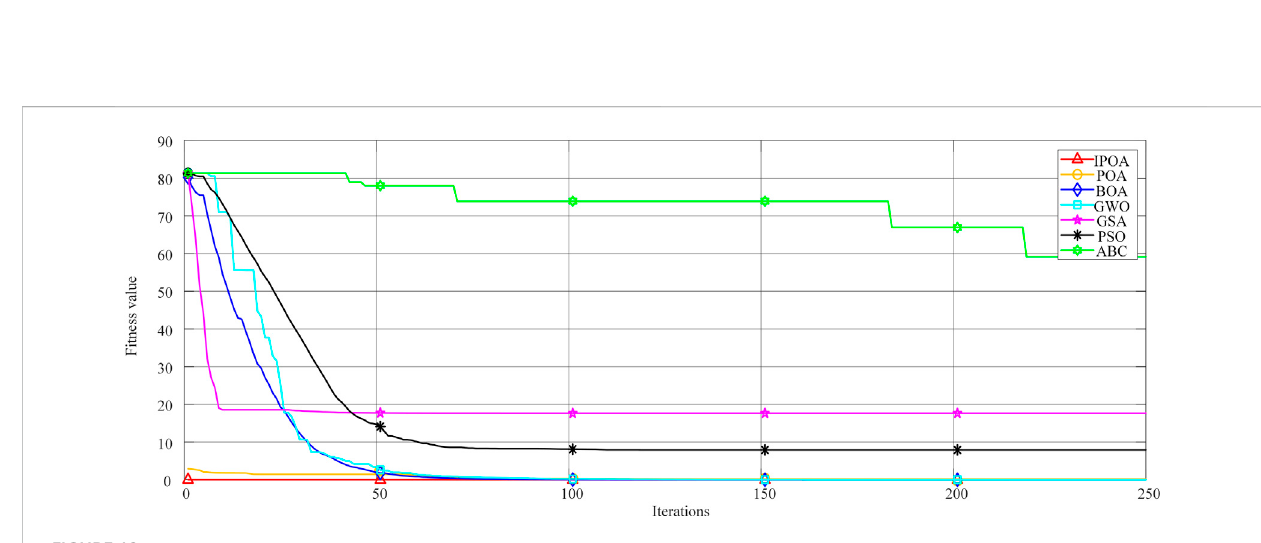
FIGURE 12 Comparison of performance between IPOA and different optimization